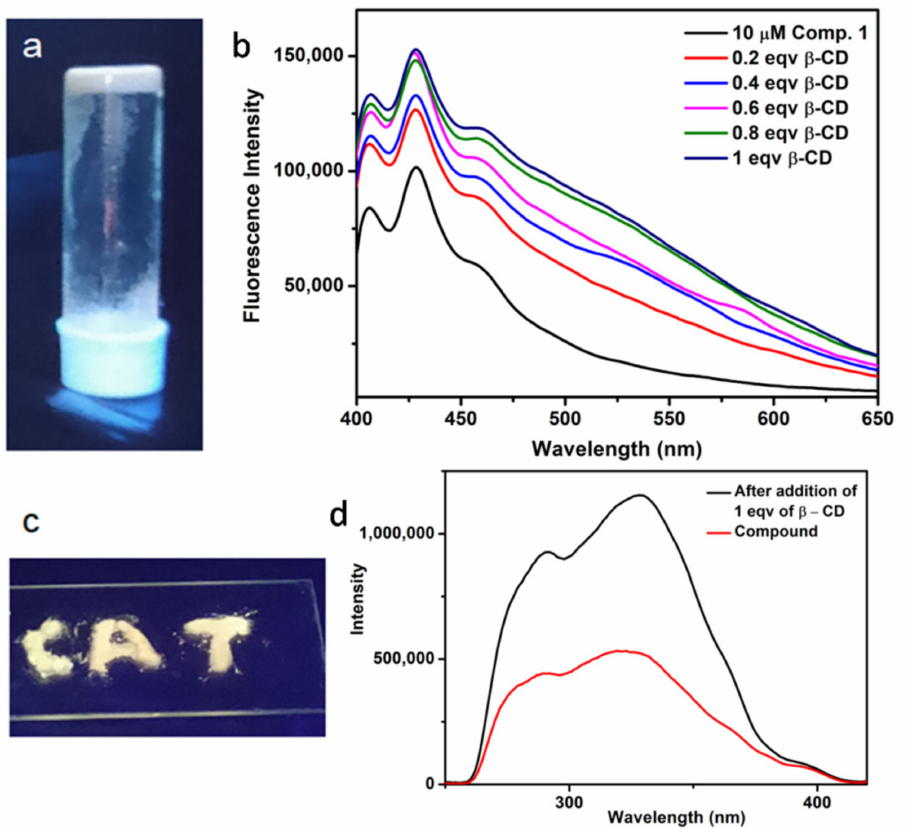
Figure 7. ( a ) The NDI 1 and β -CD gel in DMF emits white-light upon excitation by 366 nm UV-light; ( b ) The emission spectra of NDI 1 in DMF with the gradual addition of β -CD, excitation at 380 nm; ( c ) The design made by NDI 1 and β -CD gel in DMF on glass surface showing white-light emission upon excitation by 366 nm UV-lamp. ( d ) The excitation spectra at this